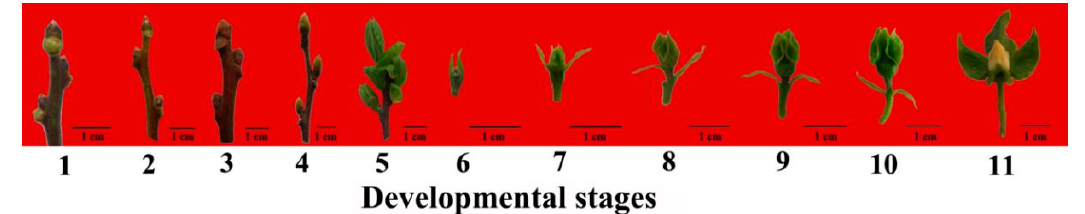
Figure 1. Male floral buds at different developmental stages (1–11).